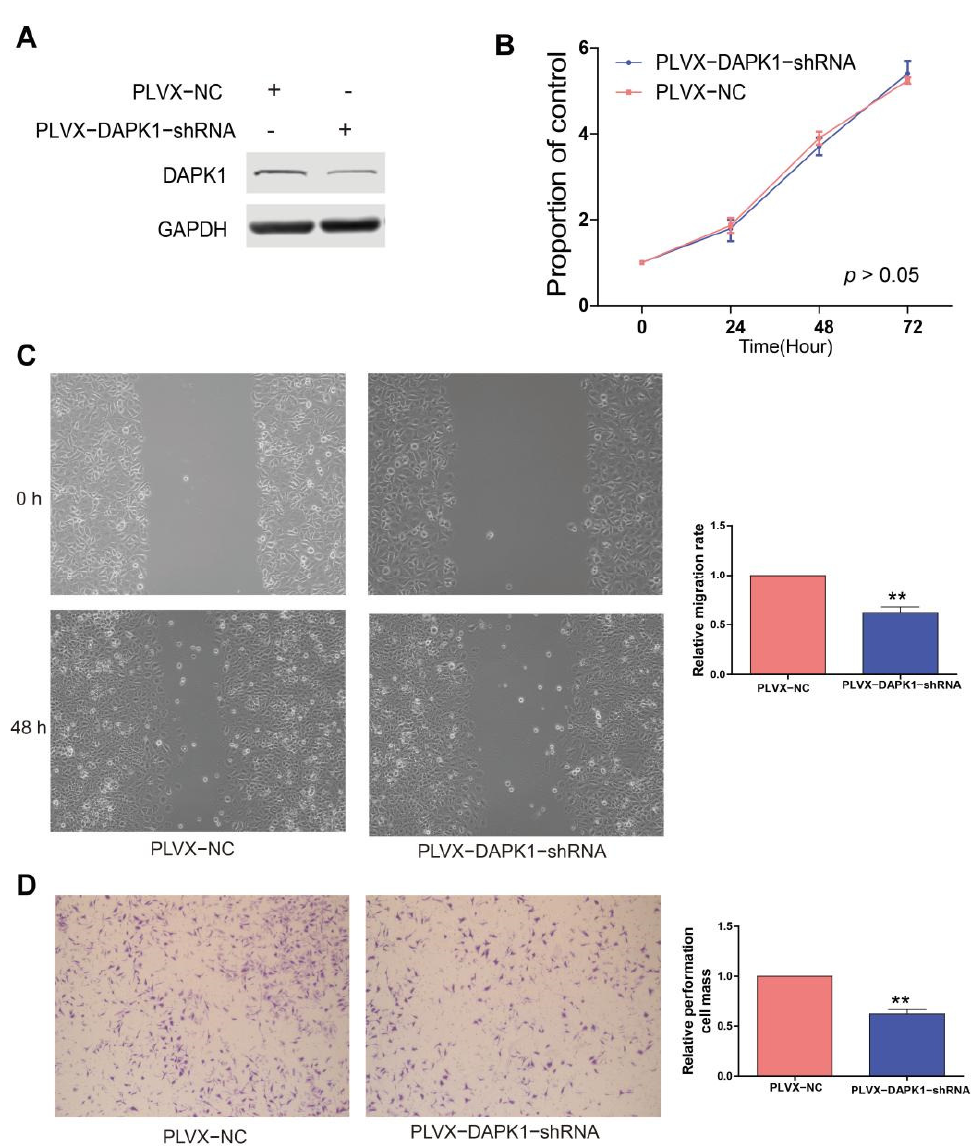
Figure 4. Knockdown DAPK1 inhibits GC cell migration and invasion. ( A ) Western blot was used to detect the levels of DAPK1 in MGC-803 cells transduced by DAPK1-shRNA; ( B ) DAPK1 knockdown did not significantly affect MGC-803 cell proliferation by using CCK8; ( C ) DAPK1 knockdown inhibited MGC-803 cell migration; ( D ) DAPK1 knockdown inhibited MGC-803 cell invasion. ** p < 0.01. Please find the original western blot of ( A ) in the Figure S1. DAPK1 overexpression plasmid has been further transfected into MGC-803 cells to analyze the effects of DAPK1 on GC cells (Figure 5A). In Figure 5B, overexpression of DAPK1 did not affect MGC-803 cell proliferation. The migration and invasion assays showed that increased DAPK1 levels promoted the invasion and migration abilities of MGC-803 cells (Figure 5C,D).